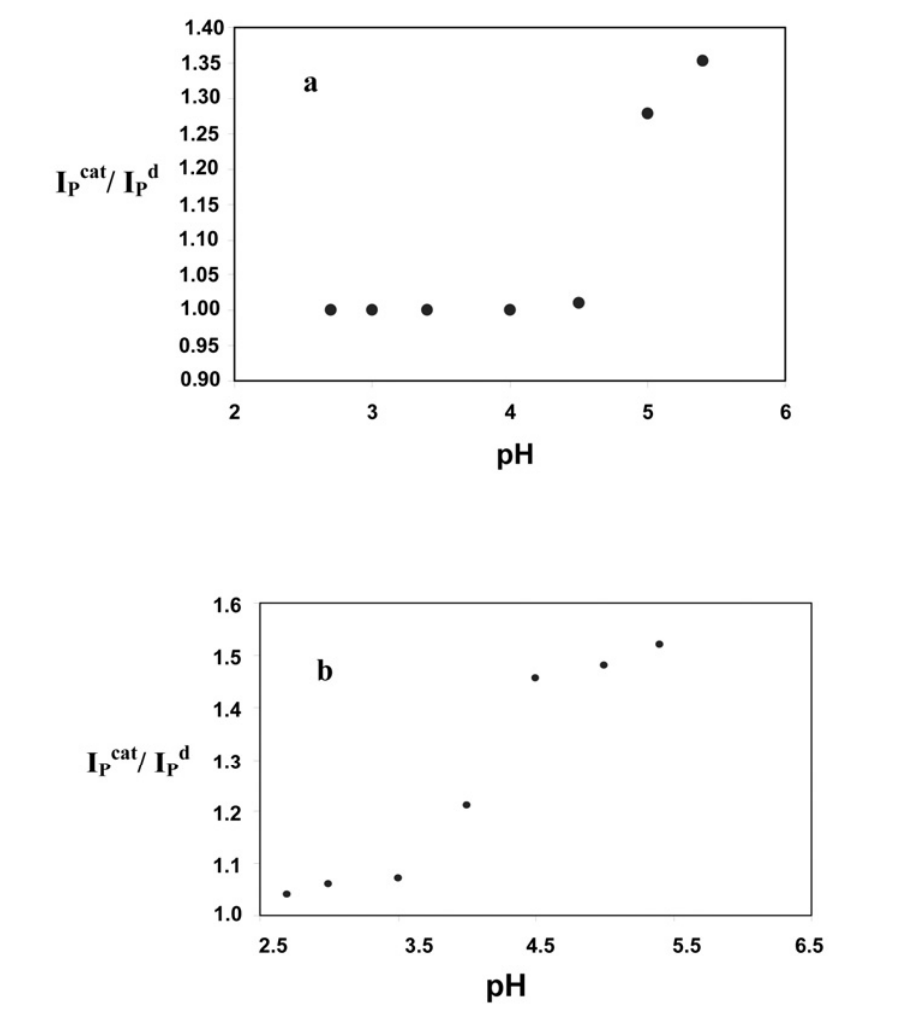
Figure 4. Plot of I pcat /I pd vs pH in McIlvaine buffer solution of (a) phenol and (b) o-cresol. Optimization of scan